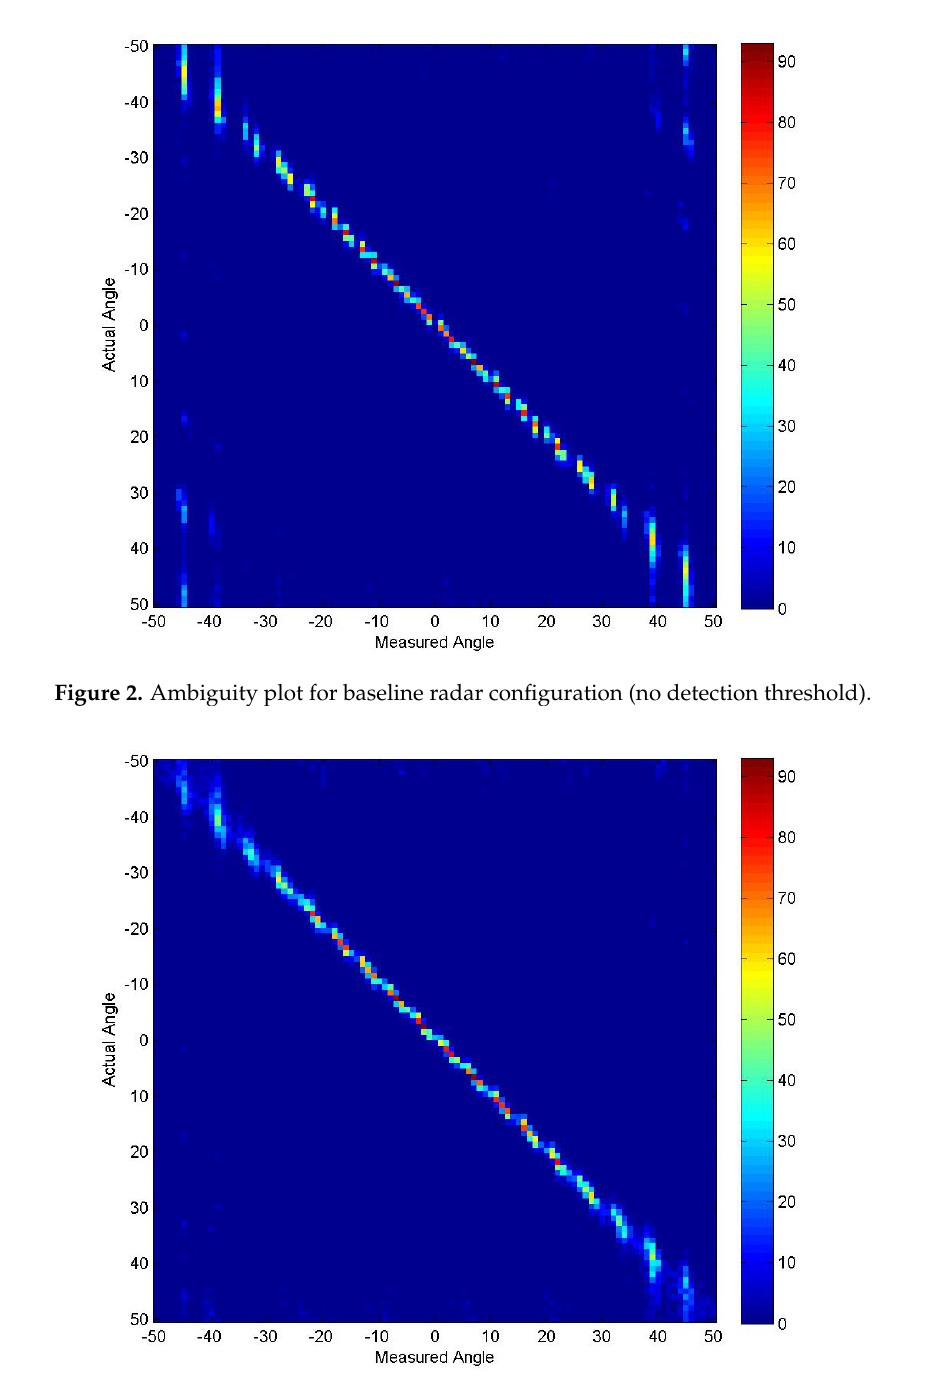
Figure 3. Ambiguity plot for baseline radar configuration (13-dB detection